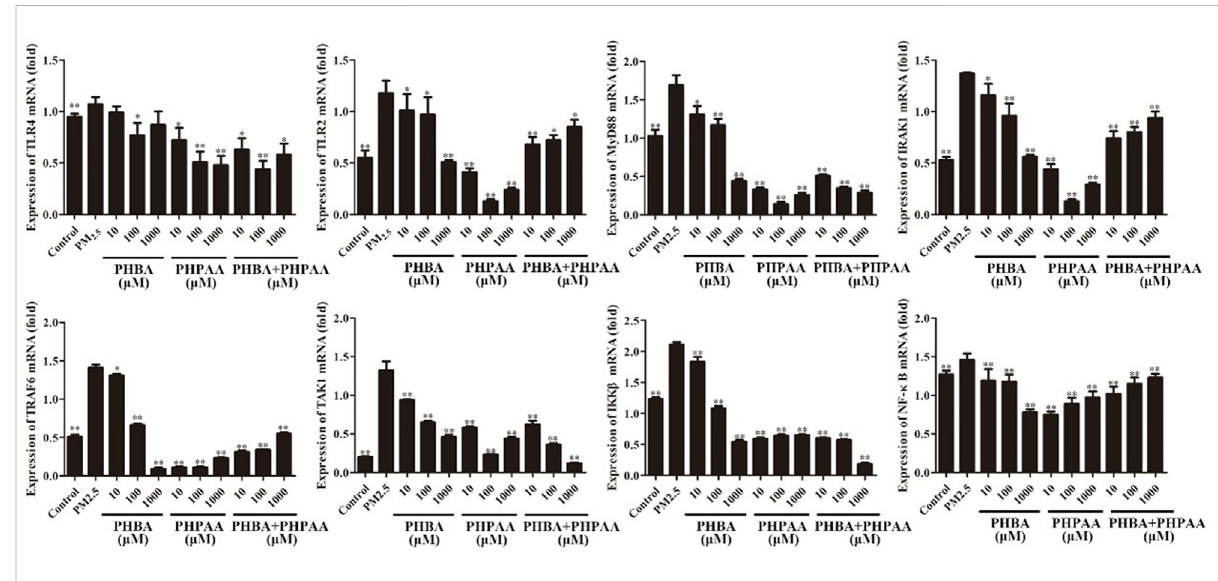
FIGURE 8 Gene expression of TLRs related pathways. Values are means ± SD from three separate experiments. Compared with PM 2.5 stimulation group, * p < .05, ** p < .01.